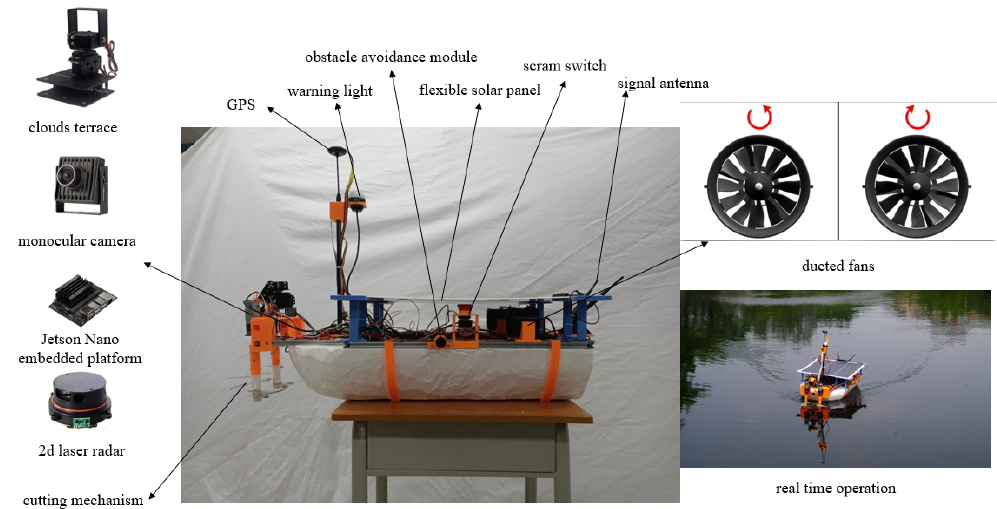
Figure 1. Unmanned Eichhornia crassipe cleaning boat.